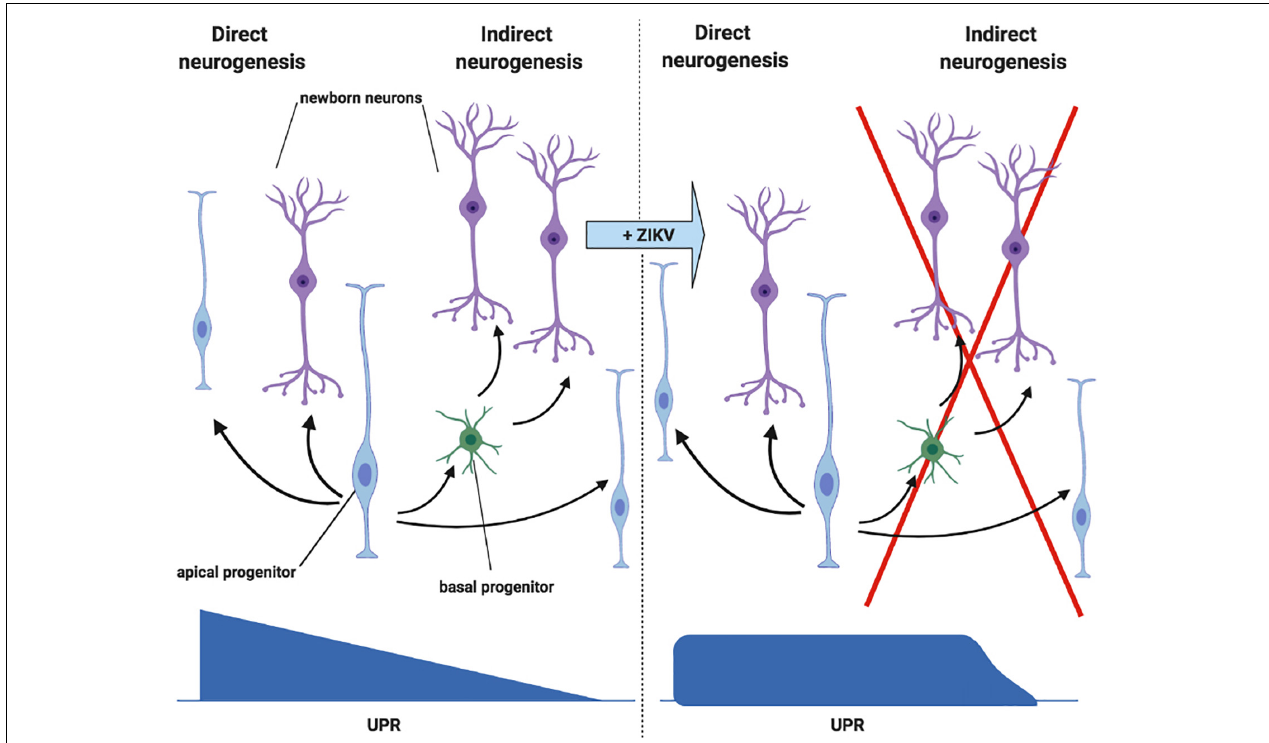
FIGURE 5 | ZIKV infection deregulates the UPR during cortical neurogenesis. Left panel: initially, direct neurogenesis occurs, whereby each apical NPC gives rise to one neuron and another apical NPC. Indirect neurogenesis is then initiated later on in development, during which basal progenitors are produced. Basal progenitors divide symmetrically to either produce two further progenitors, or two neurons. Progressive decrease in UPR activity mediates the switch from direct to indirect neurogenesis. Right panel: the shift from direct to indirect neurogenesis is inhibited by ZIKV, which increases UPR activity following infection of the NPCs (adapted from Alfano et al., 2019, created with